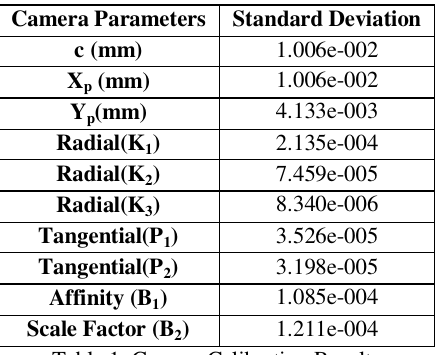
Table 1. Camera Calibration